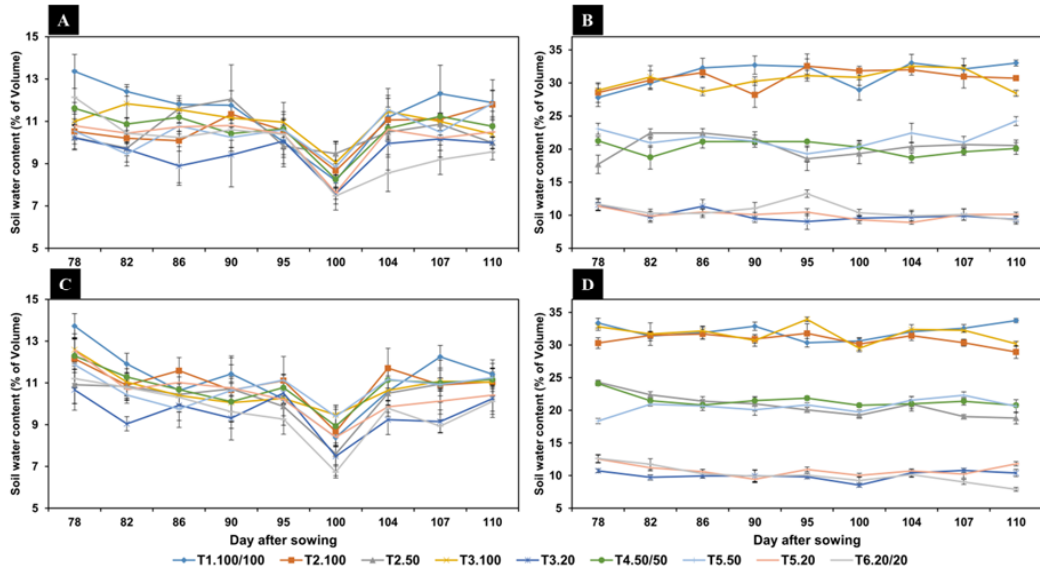
Figure 3. Moisture status of both sides of soybean roots subjected to different split ‐ root water imbalance treatments. ( A , C ) = before water application, ( B , D ) = after 2 h of water application. ( A , B ) = ND12 (drought resistant), ( C , D ) = C103 (drought susceptible). T1, 100/100; T2, 100/50; T3, 100/20; T4, 50/50; T5, 50/20; T6, 20/20.